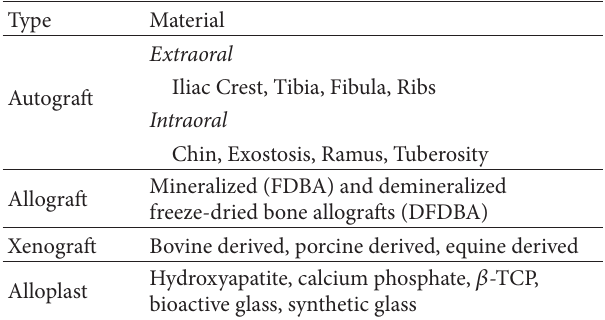
Table 2: Types of bone graft materials in periodontal